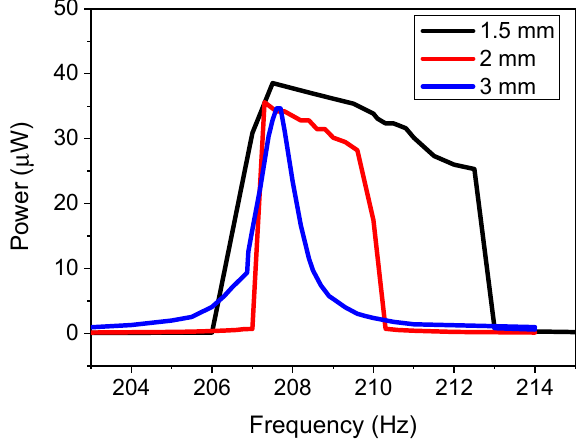
Figure 6. Experimental results of power for the in-plane single-tether configuration as a function of frequency for varying magnet spacing distances at an acceleration of 0.1g.